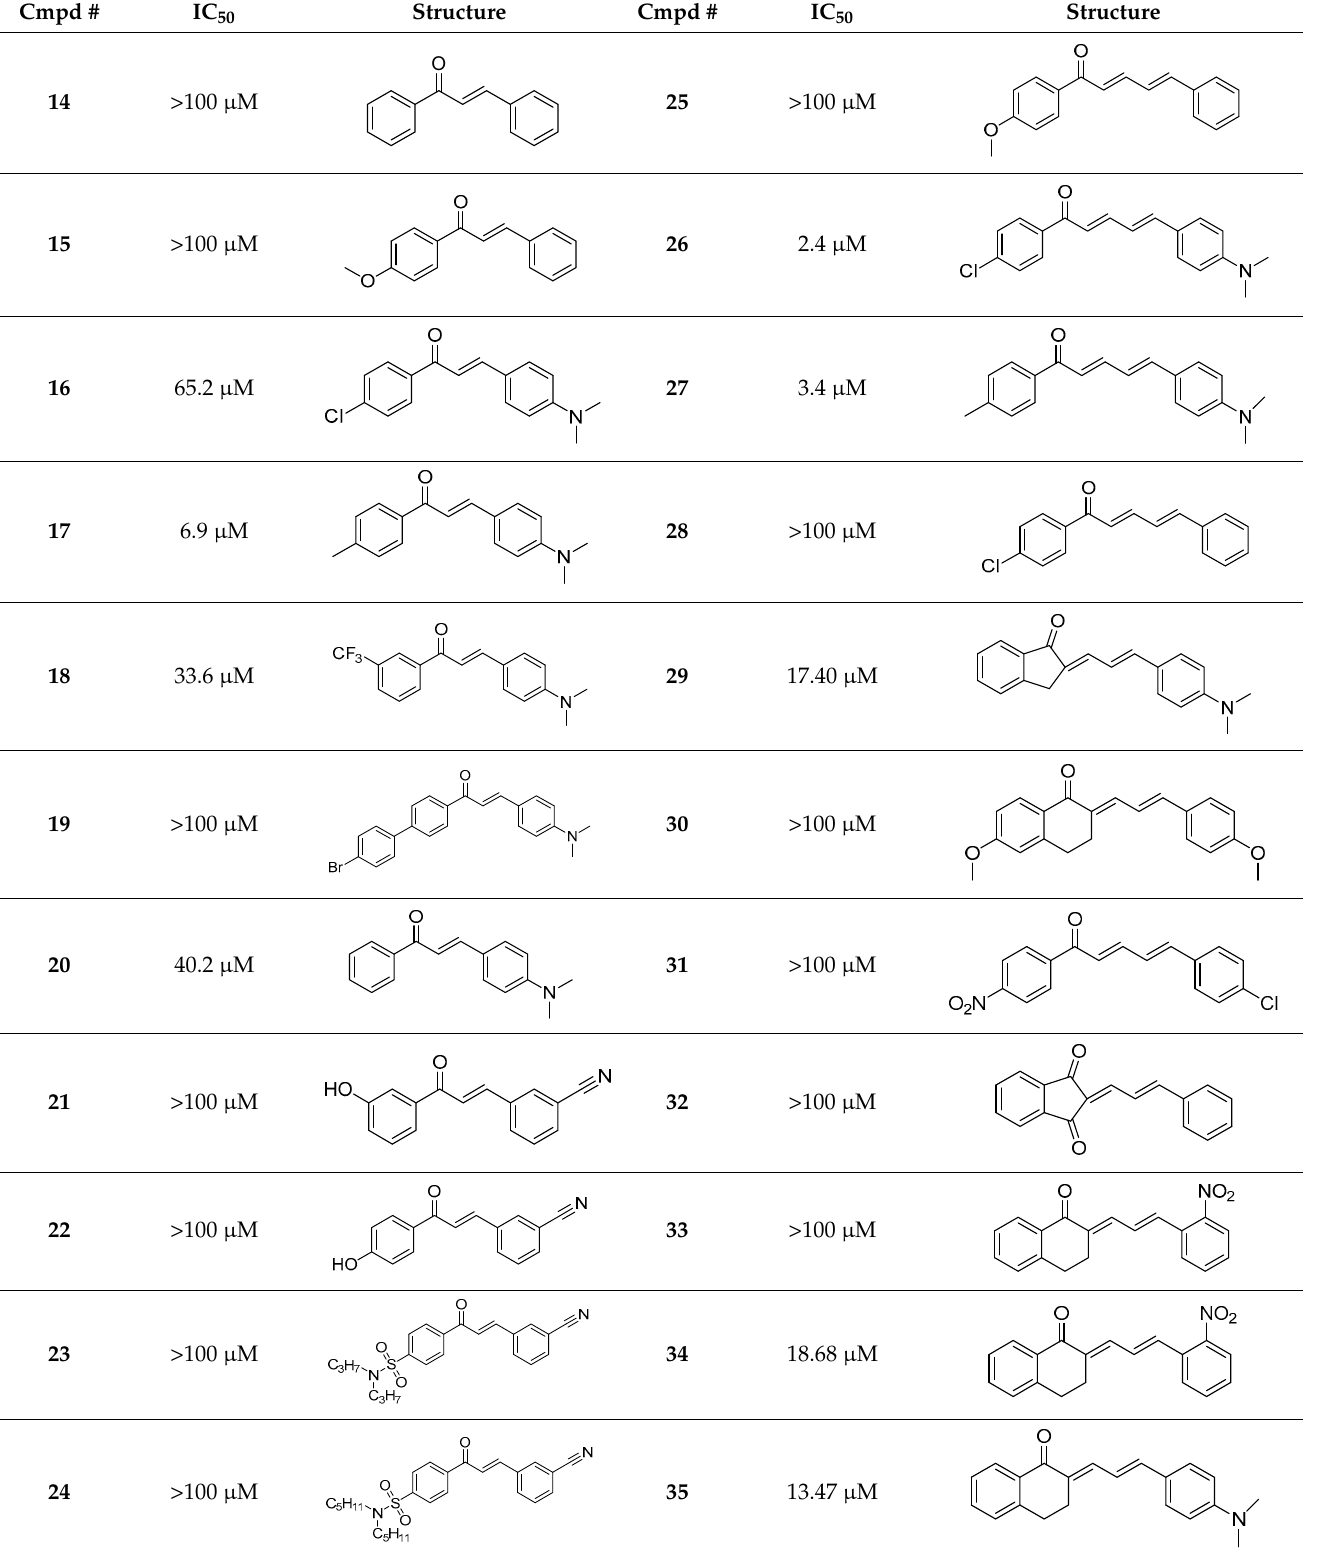
Table 2. IC 50 values of (left) chalcone and chalcone-homotaurine hybrids and (right) extended chalcones. Data reported as triplicates.